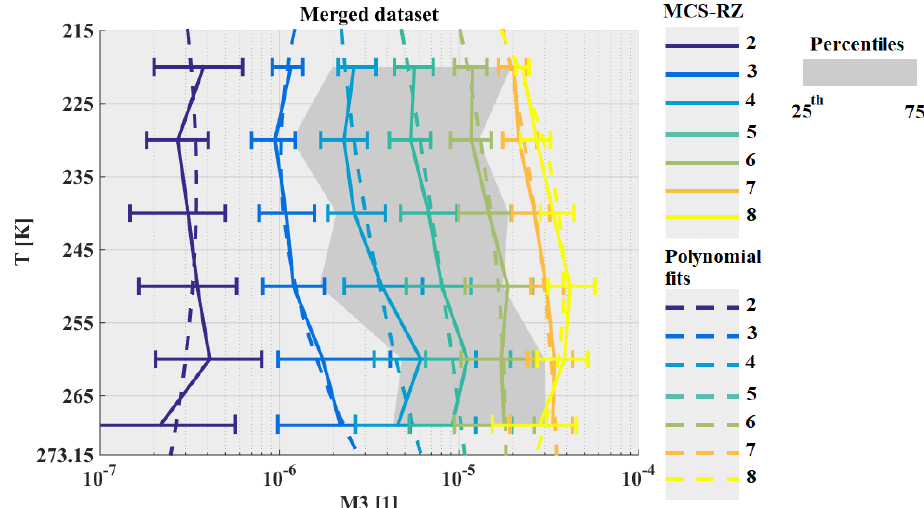
Figure 23. The same as Fig. 5 but for the M 3 for the unity dimension.